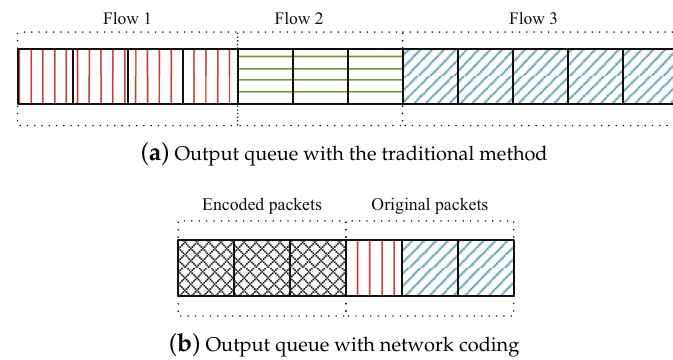
Figure 6. An example of the output queue.